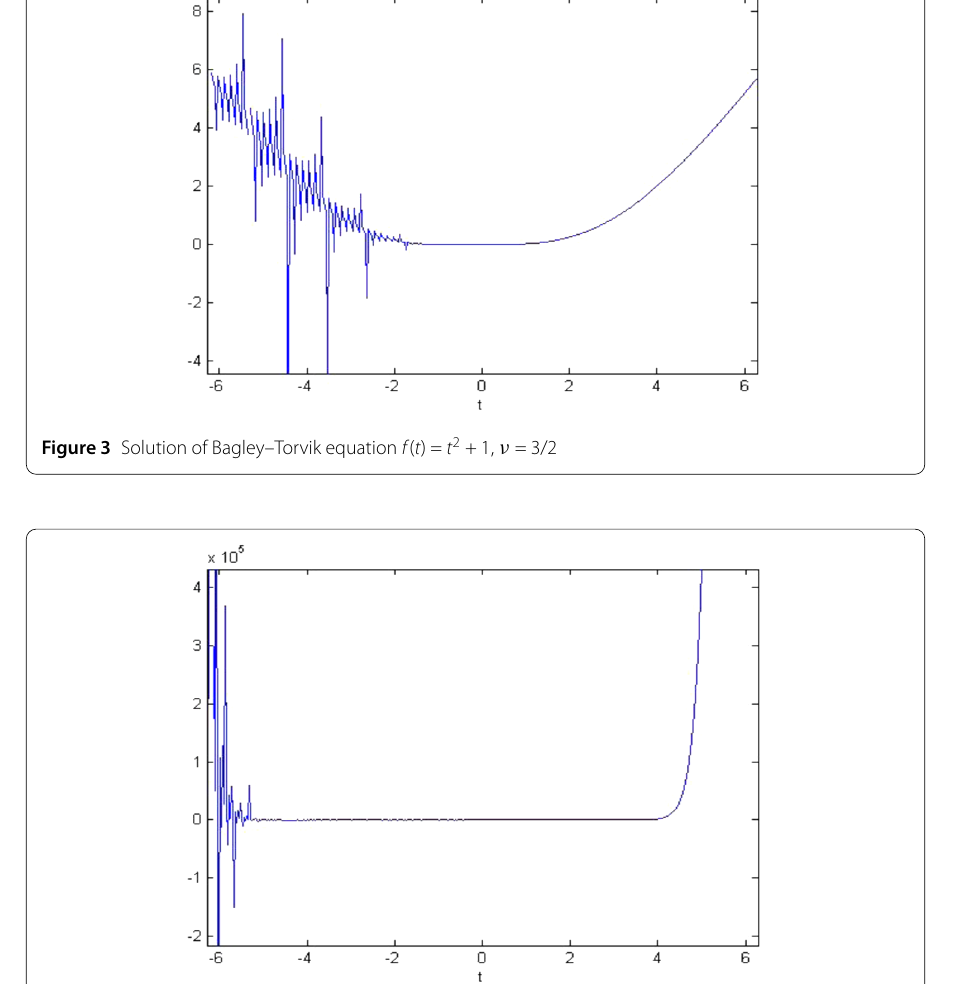
Figure 4 Solution of Bagley–Torvik equation f ( t ) = 0, ν =